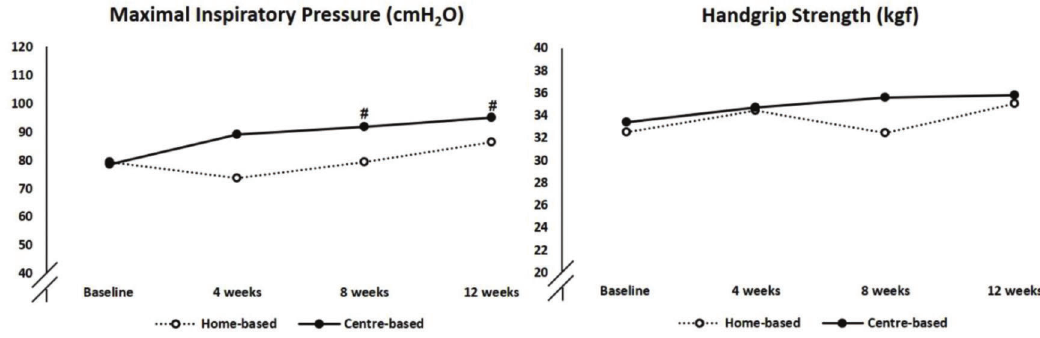
Figure 3 - Respiratory and peripheral muscle strength at baseline and at 4, 8, 12 weeks of training. # vs baseline, p =0.019 using Tukey ’ s multiple comparison